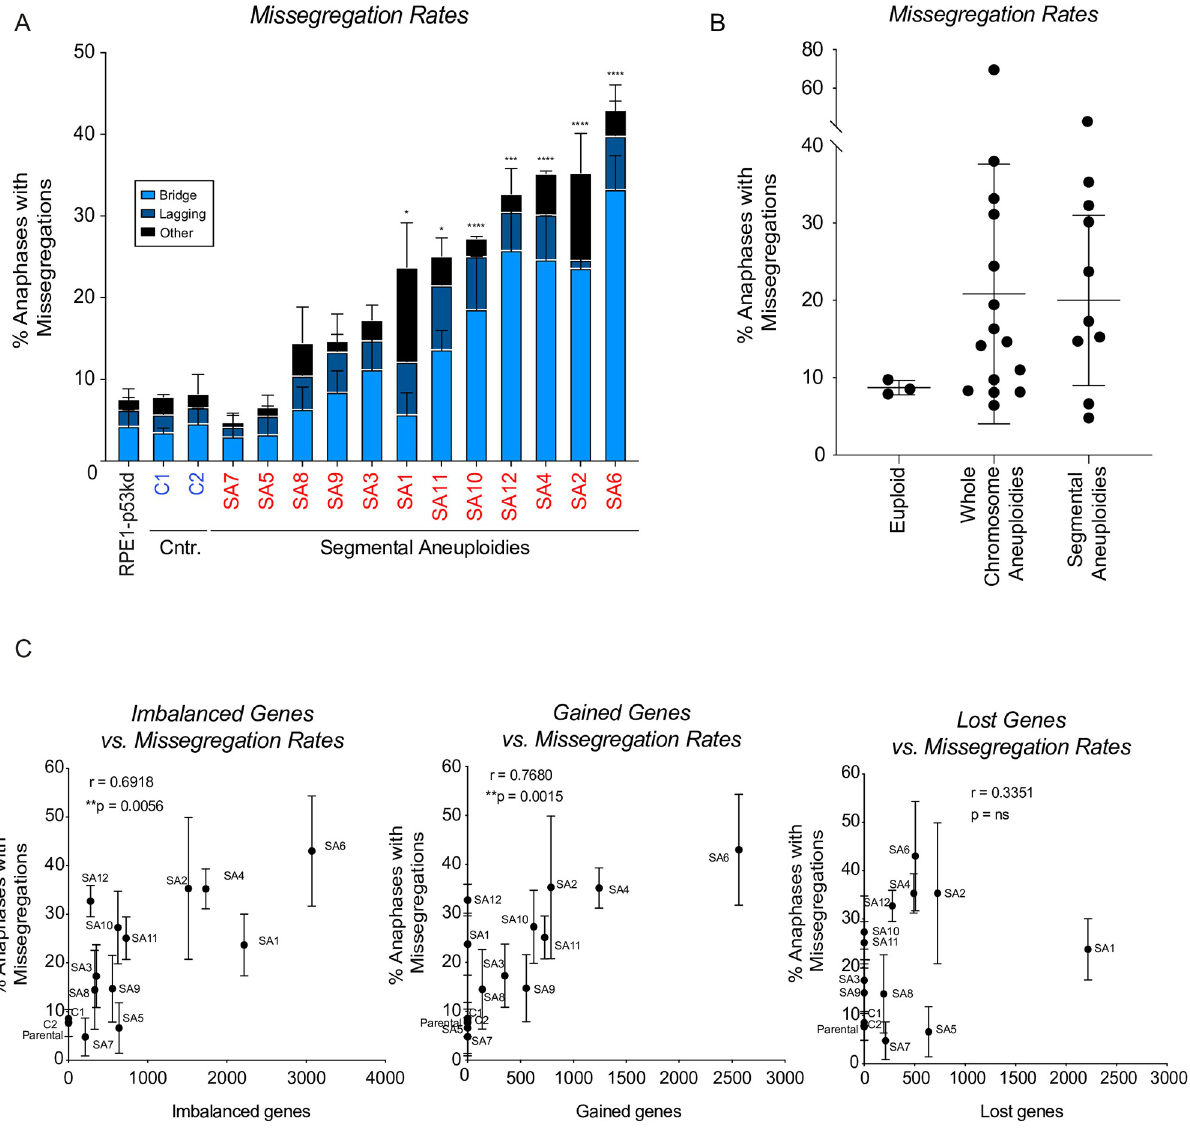
Fig 4. Segmental chromosome aneuploidies can induce CIN. A. Chromosome missegregation rates determined by live cell imaging of parental RPE-1 p53KD cells (labeled in black), euploid clones (blue) from S1 Fig and the segmental aneuploid clones (red) from S2 Fig, categorized in three different categories: lagging chromosomes or chromosome fragments, anaphase bridges and others (multipolar spindle, polar chromosome, cytokinesis failure, binucleated cell). All conditions were analyzed blinded. Bars are averages of at least 2 experiments and a minimum of 50 cells were filmed per clones. Error bars indicate standard deviation. An ordinary one-way ANOVA was performed between parental and clones. P-values are assigned according to GraphPad standard. B. Missegregation rates as determined in 1A and 4A, classified in euploid clones, clones harboring whole chromosome aneuploidies, and clones harboring segmental aneuploidies. Lines show the mean; error bars indicate standard deviation. C. Spearman correlation between the number of imbalanced, gained and lost coding genes and the level of CIN as determined in A. Error bars indicate standard deviation.